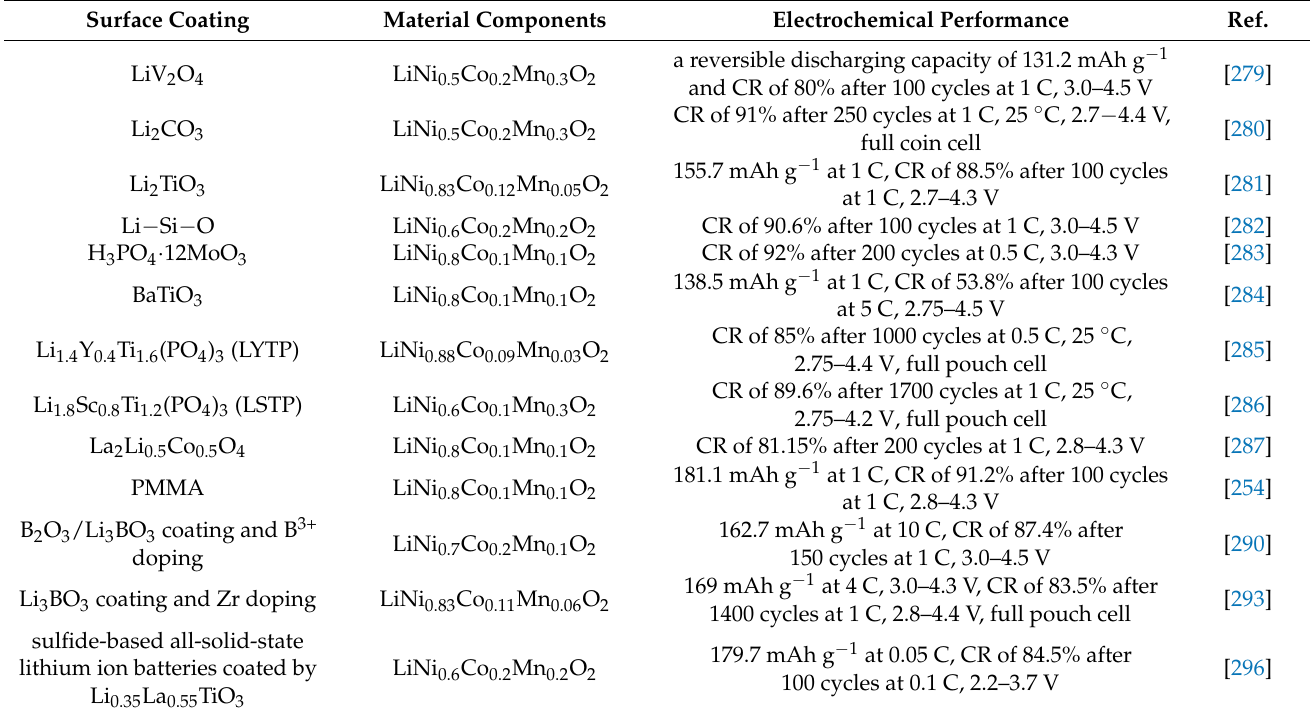
Table 3. Electrochemical properties of single-crystal nickel-rich NCM materials with different surface coatings. (CR = Capacity